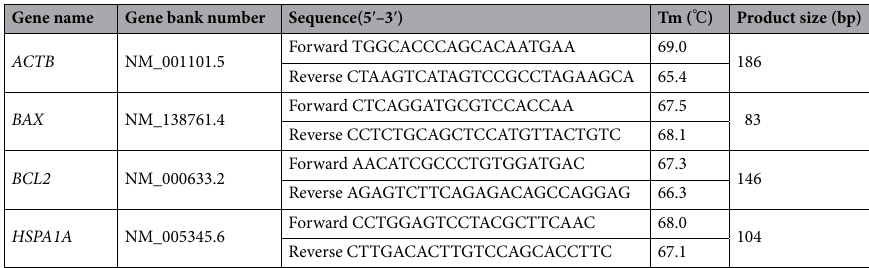
Table 1. RT-qPCR primer sequences in this